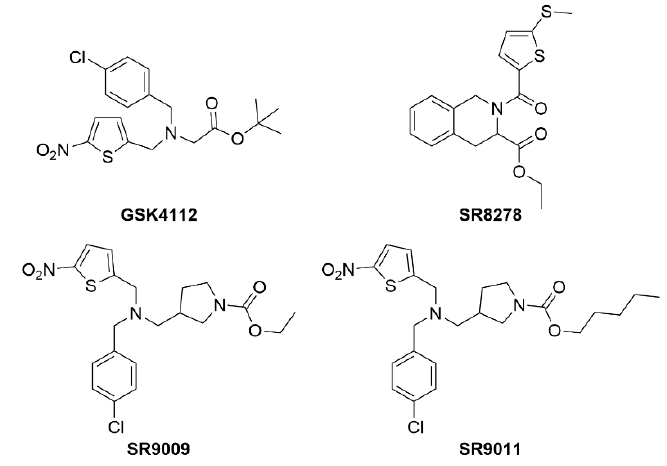
Figure 9. Structures of REV-ERB chemical tool compounds.